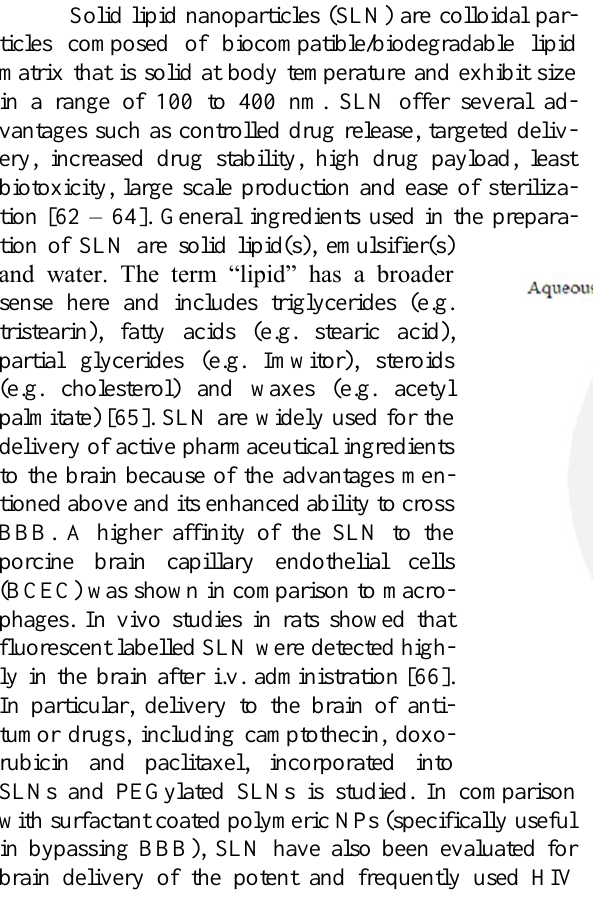
Fig. 8. Generalized structure of nanoparticle Solid lipid nanoparticles